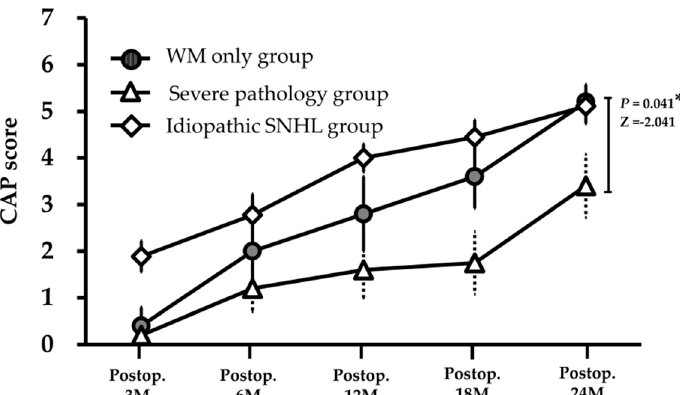
Figure 2. The progression of speech perception performance after cochlear implantation (CI) in patients with congenital cytomegalovirus (cCMV) infection and idiopathic sensorineural hearing loss (SNHL). Among the participants with cCMV infection, the mild pathology group having only limited white matter (WM) abnormalities in their MRIs showed rapid progression of speech perception performance after CI. At 2 years after CI, the categories of auditory performance score of mild pathology group was similar to that of the idiopathic SNHL group, whereas the CI outcomes of the severe pathology group with one or more of cCMV infection-related severe pathologic MRI findings, was significantly poorer than the mild pathology group and idiopathic SNHL group.